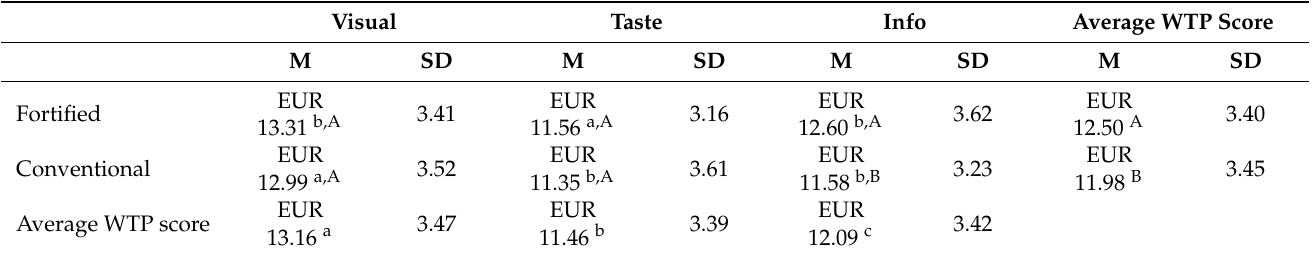
Table 7. Overall WTP for fortified/conventional fish according to the stage of detection in the second experimental condition (visual, taste, and information) 1